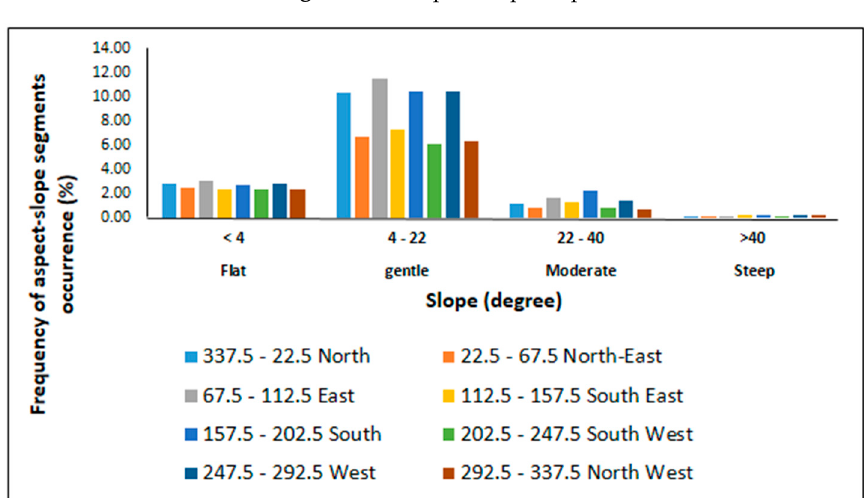
Figure 8. Frequency distribution of aspect-slope rooftop segments.